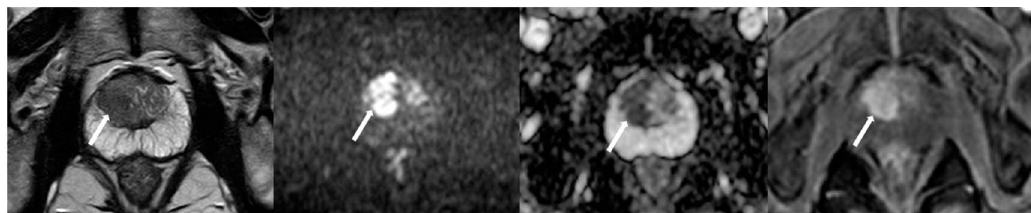
Figure 3. Case of prostate cancer in TZ. Male, 63 years old, prostate cancer with its longest diameter being >1.5cm. T2WI showed a hypointense nodule (arrow) in the right TZ ( A ). The lesion was hyperintense on DWI (b = 1500 s/mm 2 ) (arrow) and hypointense on ADC images ( B , C ). Positive enhancement was seen on the DCE (arrow) ( D ). The lesion was finally assessed as a PI-RADS category 5, indicating that it had a high cancer risk according to PI-RADS v2, PA PI-RADS v2, and biparametric MRI protocols. Figure 4. Case of benign prostate hyperplasia. Male, 64 years old, benign prostate hyperplasia. T2WI showed multiple slightly hypo/hyper-intense encapsulated nodules in TZ ( A ). The lesion was isointense on the DWI and ADC map ( B , C ). A diffuse popcorn-like enhancement was seen on the DCE and was assessed as negative ( D ). It was finally assessed as a category 2, indicating that it had a low cancer risk according to PI-RADS v2, pa PI-RADS v2, and biparametric MRI pro- tocols.